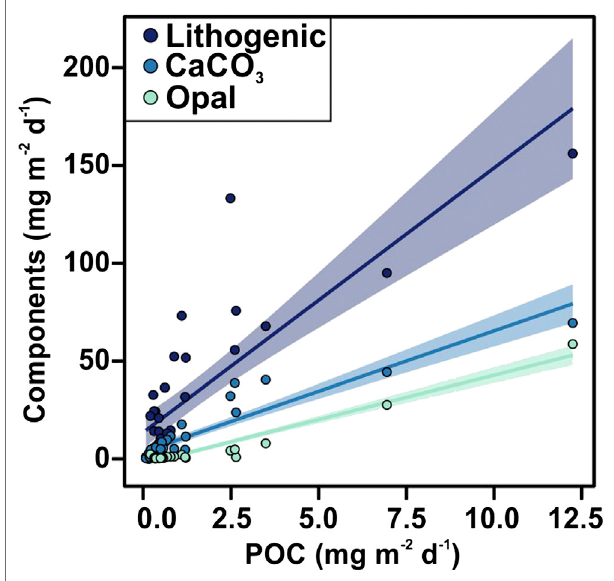
FIGURE 5 | Scatter plot of POC fl ux vs. lithogenic, CaCO 3 and opal material fl uxes. The shaded areas represent prediction interval at the 95% con fi dence